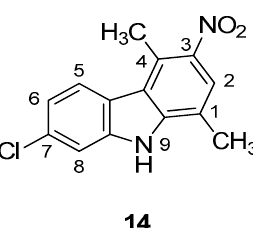
Figure 5. Structure of 7-chloro-1,4-dimethyl-3-nitro-9 H -carbazole ( 14 ).